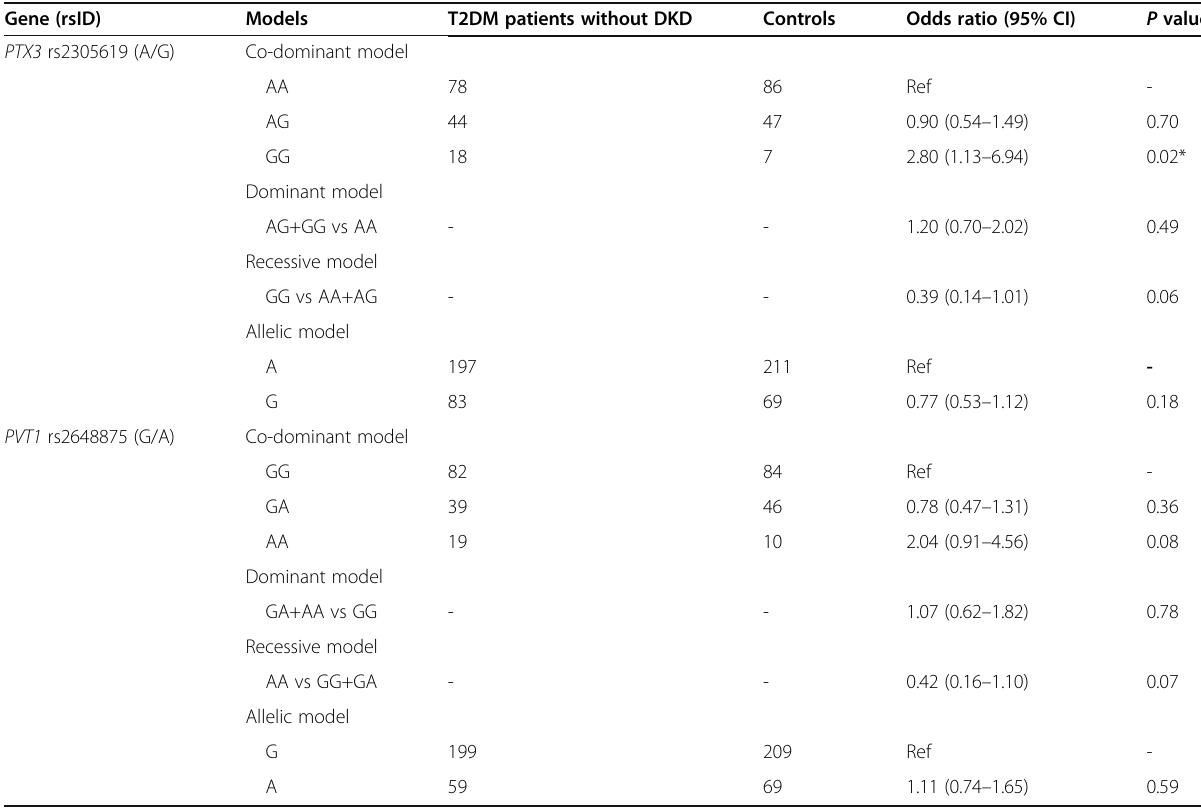
Table 3 Association of PTX3 and PVT1 gene polymorphism in T2DM patients without DKD and controls Gene